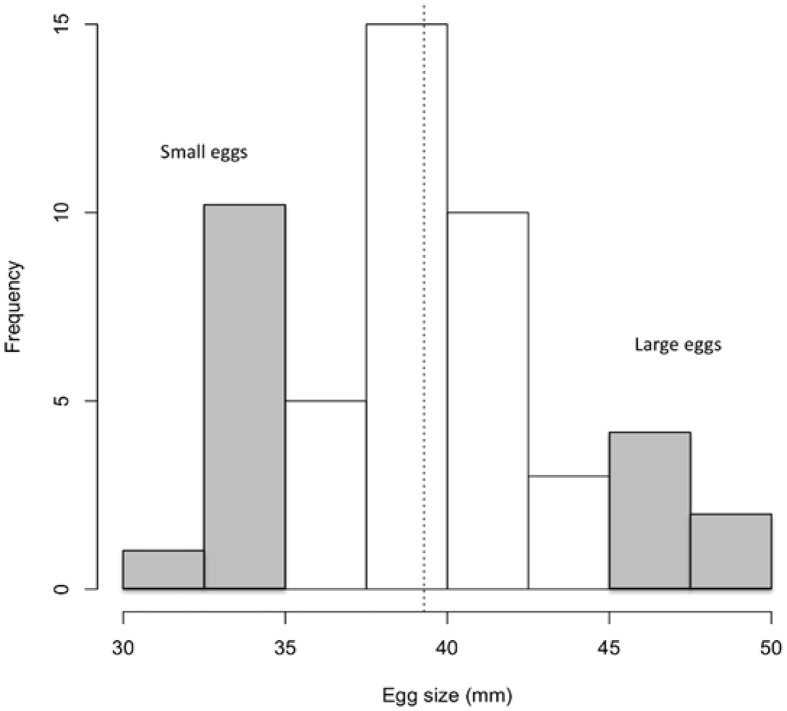
Egg size distribution of Icelandic Arctic charr (Salvelinus alpinus).Eggs were obtained from 15 females and four males (all age 4) from a fourth-generation breeding program at Hólar University College. The dashed line represents the mean egg size in the distribution 39.28 ± 4.72 mm (mean ± SD; median = 39 mm). The grey bars represent the larger and smaller eggs that were selected for the experiment.